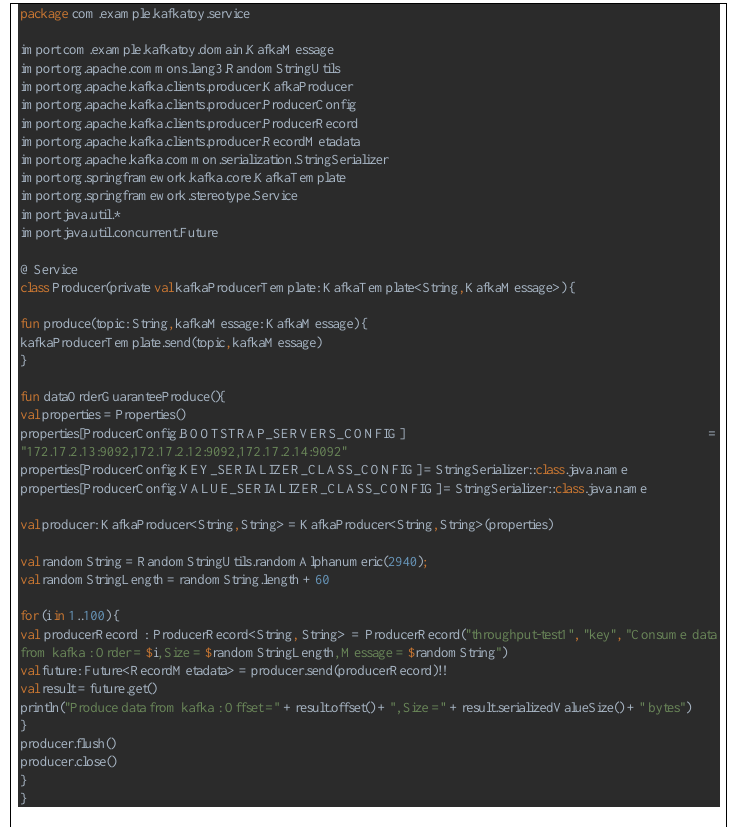
Figure 19. Source code of performance evaluation for producer.